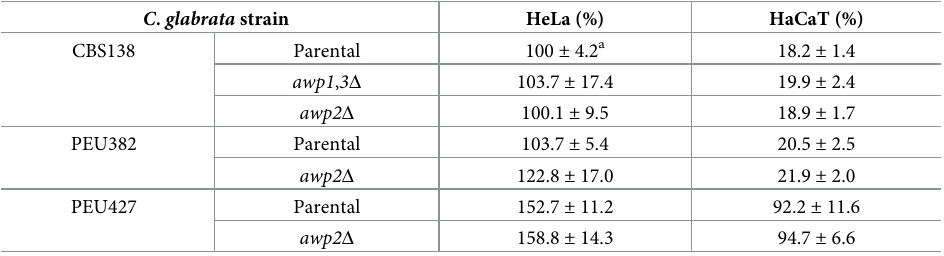
Table 1. Adhesion of C . glabrata awp mutants and parental strains to human HeLa and HaCaT cells. C . glabrata